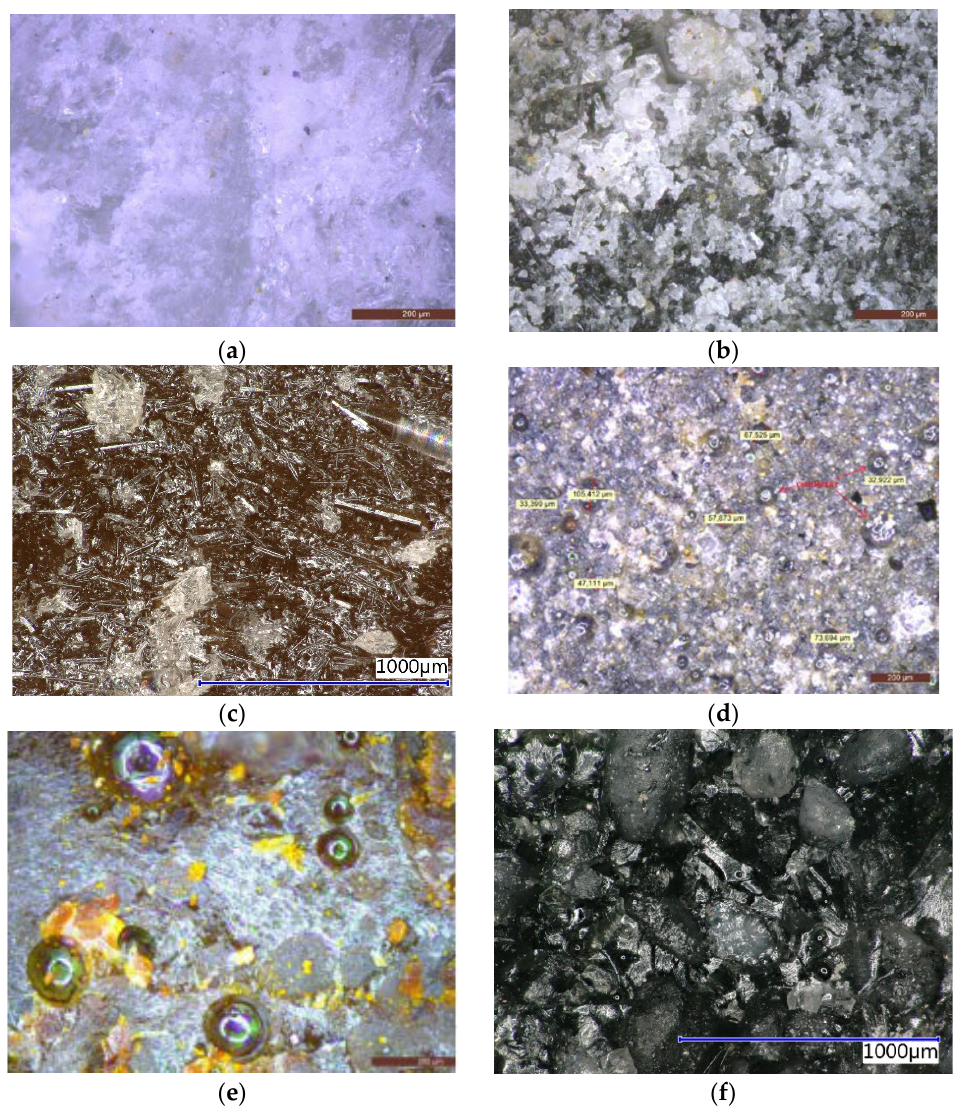
Figure 16. Detail of the structure of prepared epoxy composites with different filler using the digital microscope: ( a ) REF—Silica sand 100 × ; ( b ) WGS—Waste glass from solar panels QS Solar 100 × ; ( c ) RGI—Recycle material from the production of glass insulation 200 × ; ( d ) FA—Fly ash 200 × ; ( e ) NS—Neutralisation sludge 100 × ; ( f ) WFS—Waste foundry sand 200 ×